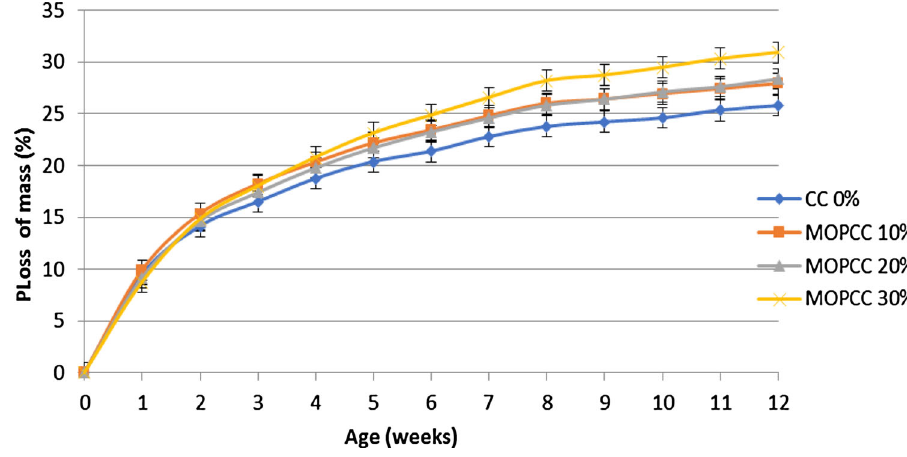
Fig. 10 Mass loss of concretes aged 90 days and immersed in H 2 SO 4 solution.